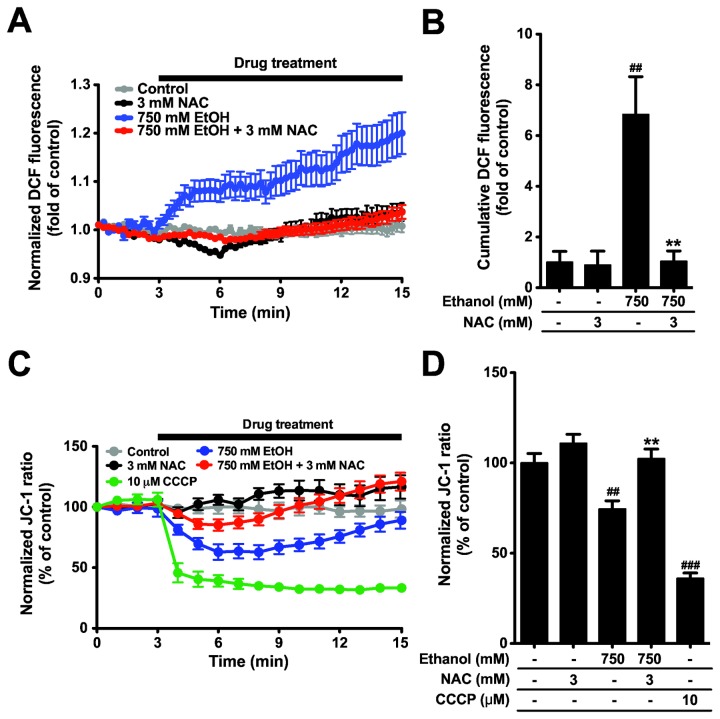
Ethanol evokes ROS generation and mitochondrial depolarization, which are blocked by an antioxidant, NAC.(A and B) ROS measured with CM-H2DCFDA. The areas under the curves and above the 1.0 level were calculated during drug treatments (3 to 15 min) and normalized to that of the control. (C and D) Mitochondrial membrane potential (MMP) measured with JC-1 dye. Decrease of ratio (F561/F488) indicates MMP depolarization. For the bar graph (D), MMP was evaluated as averages during drug treatments. Note that 3 mM NAC reversed ROS generation and MMP depolarization induced by ethanol. N = 7 - 23 for each condition, ##
P < 0.01 and ###
P < 0.001 compared to the control. ** P < 0.01 compared to the ethanol-treated group.